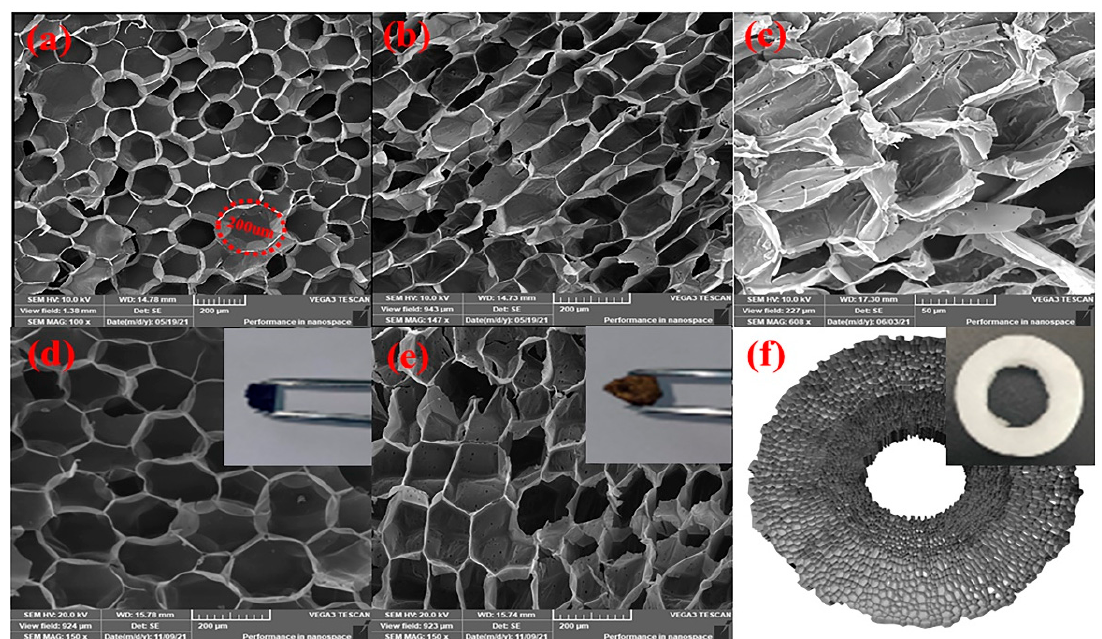
Figure 1. SEM images of MT ( a ) cross-section, ( b ) radial-section, and ( c ) tangential-section. SEM images of MT cross-section after adsorption of ( d ) MB, ( e ) CV. ( f ) The 3D simulation of the MT spatial structure .